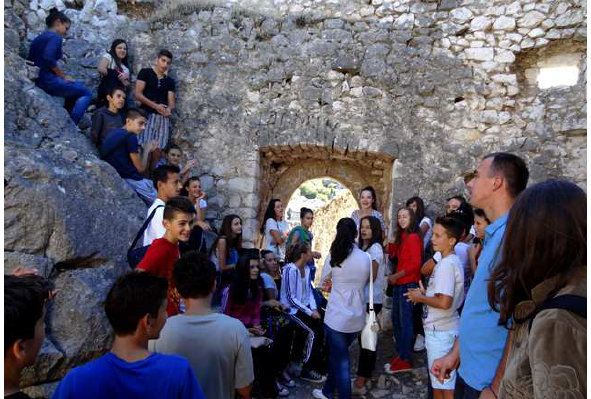
Figure 2 - Various groups of participants took part in the project including school children, young people, university students, professionals and